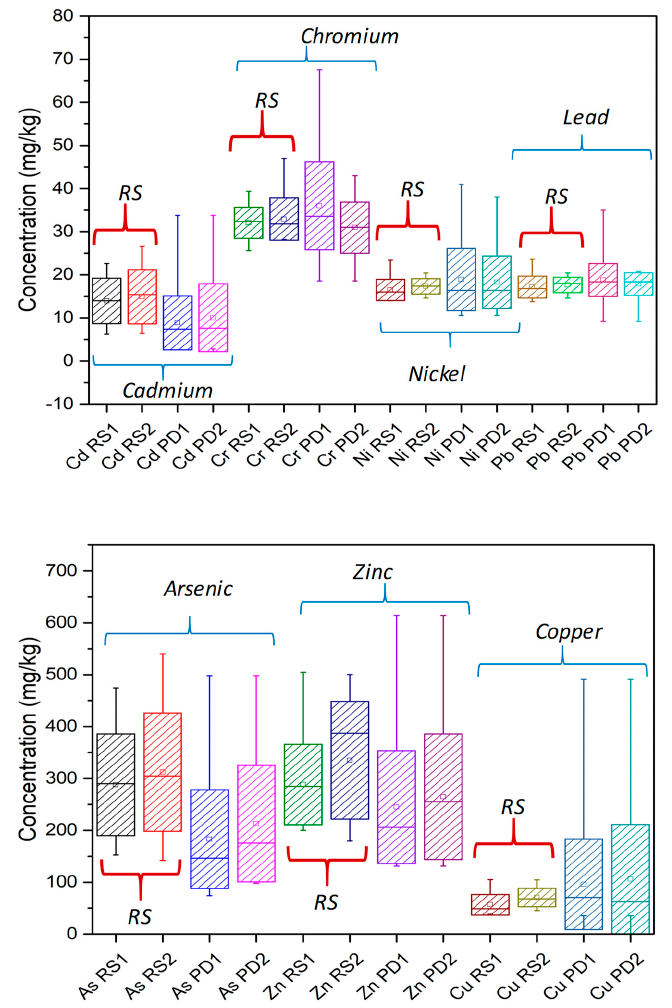
Figure 8. Comparison of selected trace metal / metalloid concentrations between the paleoflood deposits sampled along reaches RS and PD. Statistically significant differences ( p = 0.01) exist between the two reaches for As, Cd, Cr, and Zn.